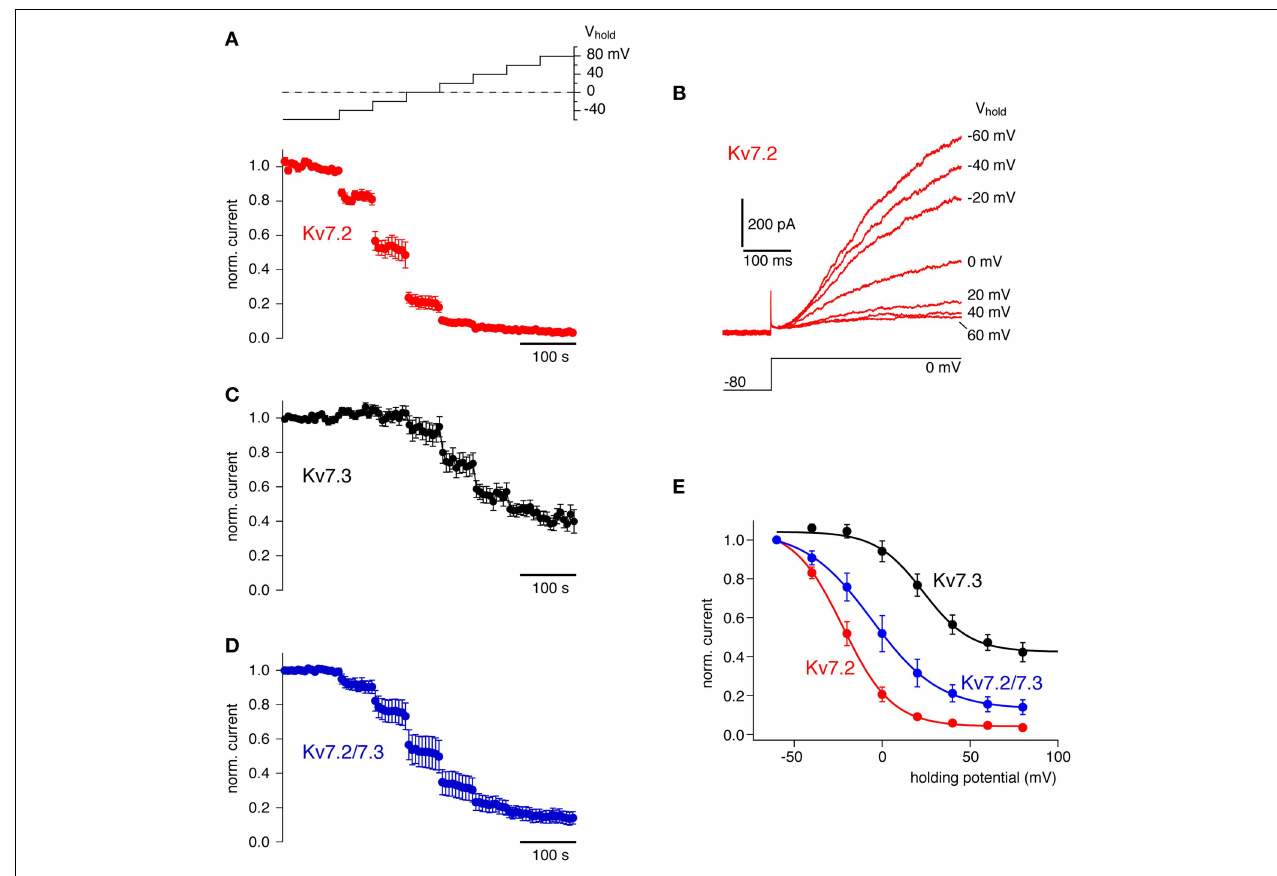
evoked by the voltage step protocol indicated at the end of each stair-step of the holding potential (as indicated for each trace). (C) Response of homomeric Kv7.3 channels to gradual activation of co-expressed Ci-VSP ( N = 11 cells), recorded as in (A) . (D) Response of heteromeric Kv7.2/7.3 channels to gradual activation of co-expressed Ci-VSP ( N = 8 cells), recorded as in (A) . (E) Mean residual currents at the end of each step of the holding-potential reveal the general sigmoidal dependence of current inhibition on the degree of activity of Ci-VSP and show distinct isoform-specific sensitivities. Continuous lines indicate fits of a Boltzmann function to the averaged data for each channel isoform.